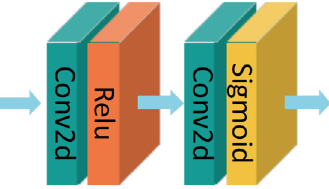
Figure 6. Structural diagram of the pixel attention module.